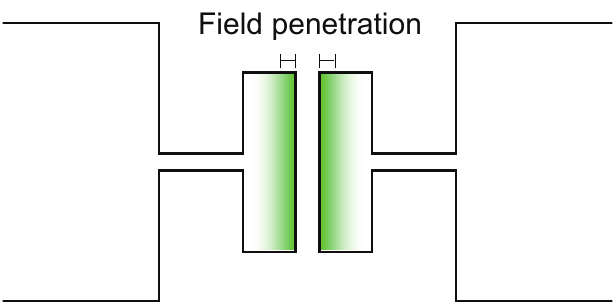
Figure 4. Schematic of the mesoscopic capacitor model. The color gradation schematically represents the field penetration mentioned in the